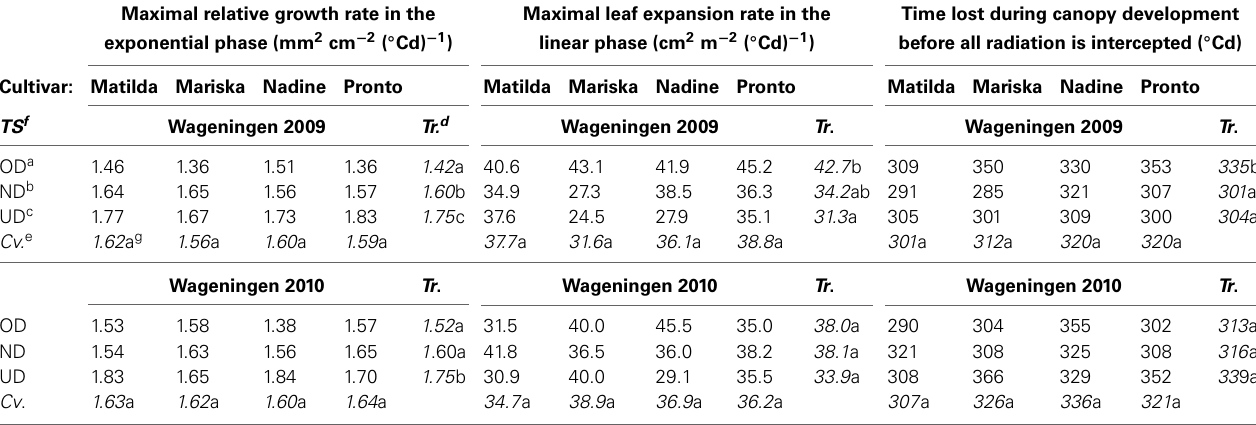
Table 4 | Values for curve fit parameters when applying an expolinear model (Goudriaan and Monteith, 1990) for leaf area expansion against thermal